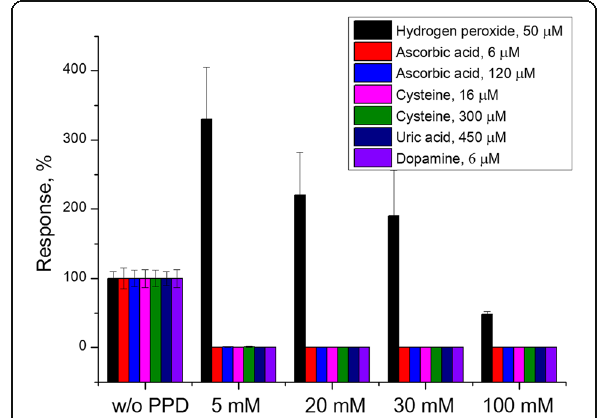
Fig. 4 Efficiency of PPD membranes deposited at different phenylenediamine